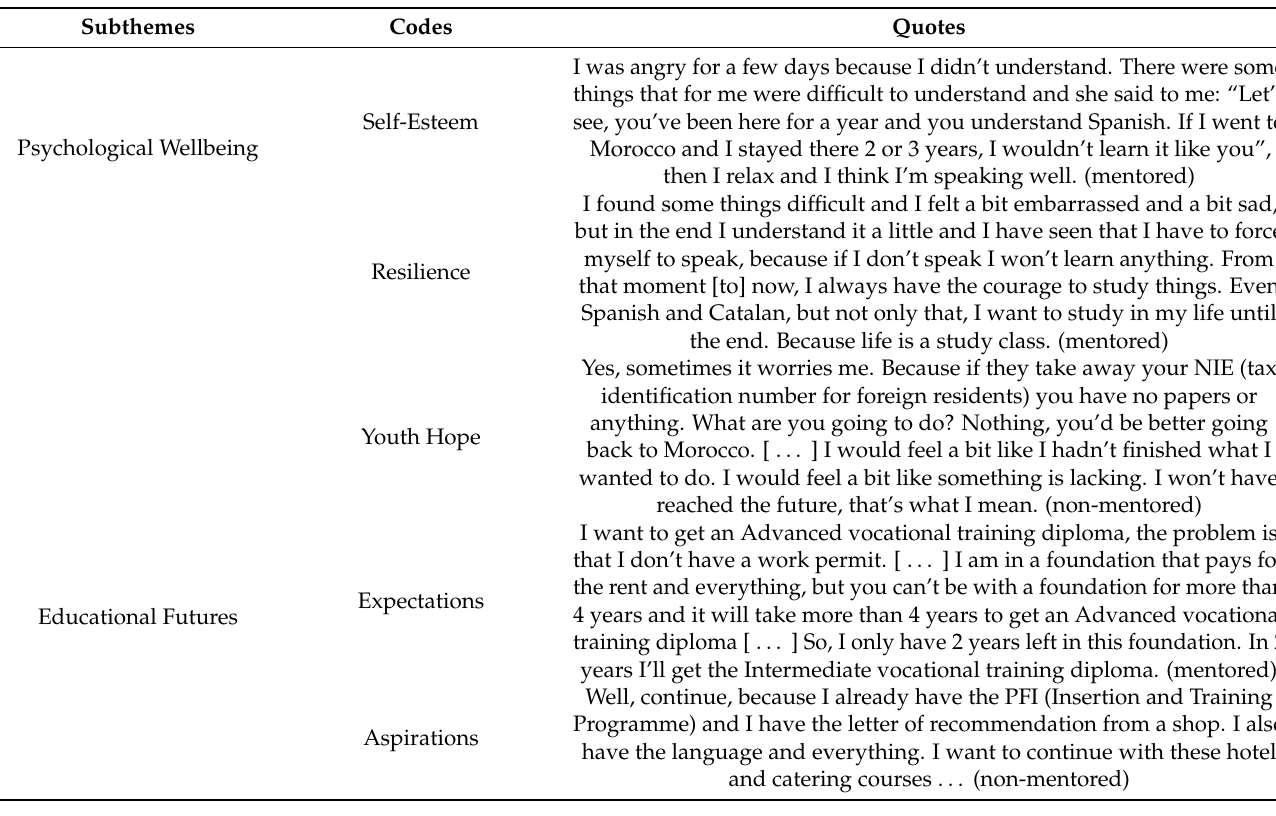
Table 1. Subthemes, codes, and quote examples.